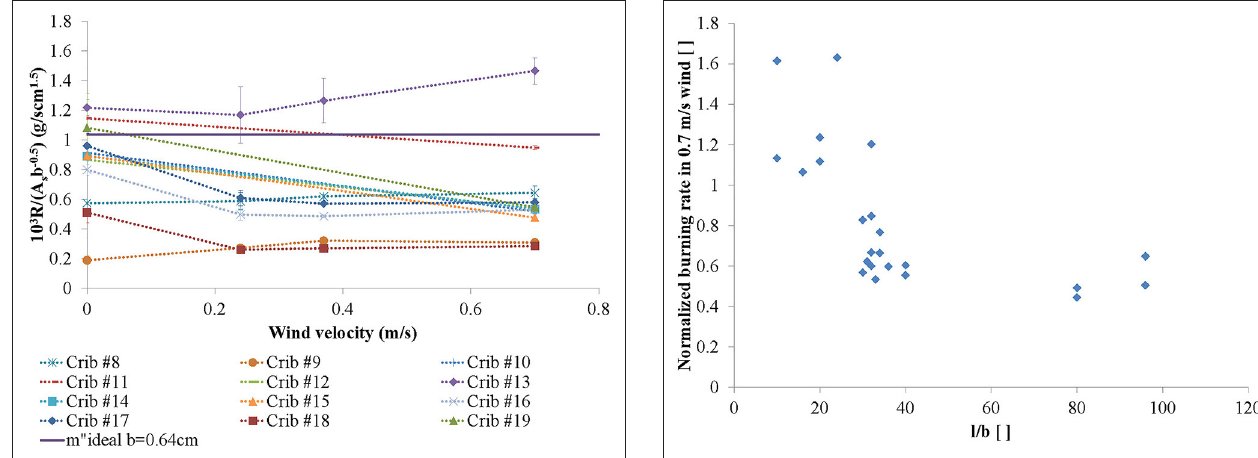
FIGURE 7 | Scaled burning rate for cribs with 0.64cm thick sticks. Ideal burning rate is from Tewarson and Pion (1976). See Table 1 for details on fuel bed parameters.